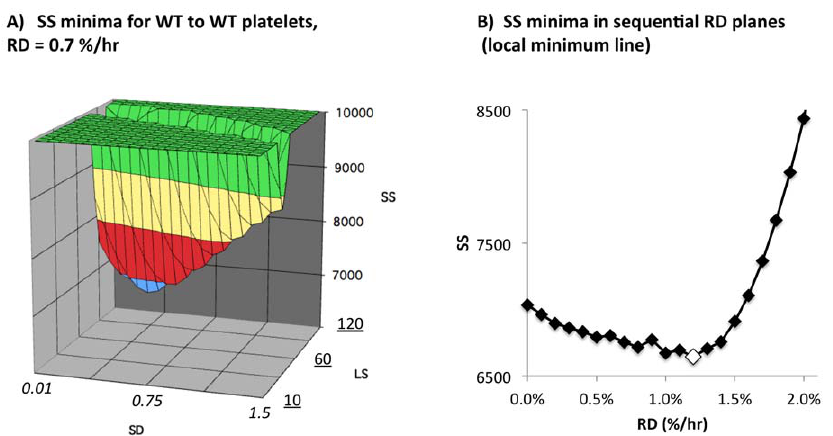
Figure 4. Optimal parameter search method. A) Shown are SS values for a 20 6 20 array of SD and LS parameter values at an RD value of 0.7%. The values shown are the squared residual values for a total of 120 WT platelet consumption measurements (30 WT recipients, four time points per recipient). The platelet consumption data used to generate the SS values is shown in figure 4. B) Shown are SS minima for a series of RD planes. The white diamond indicates the global minimum identified in this set of analyses. Details concerning the parameters space searched are in text S1.